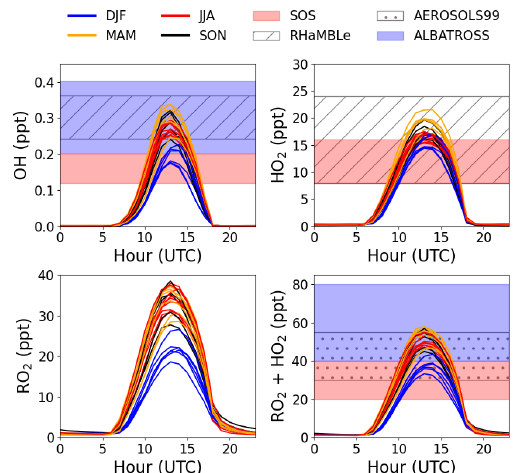
Figure 2. Average monthly diurnal cycles of modelled OH, HO 2 , RO 2 , and HO 2 + RO 2 coloured by season compared to midday measurements during SOS (February, May, September, and Novem- ber) (Carpenter et al., 2010; Vaughan et al., 2012), RHaMBLe (May and June) (Whalley et al., 2010), AEROSOLS99 (January and February) (Hernández et al., 2001) and ALBATROSS (November and December) (Burkert et al.,